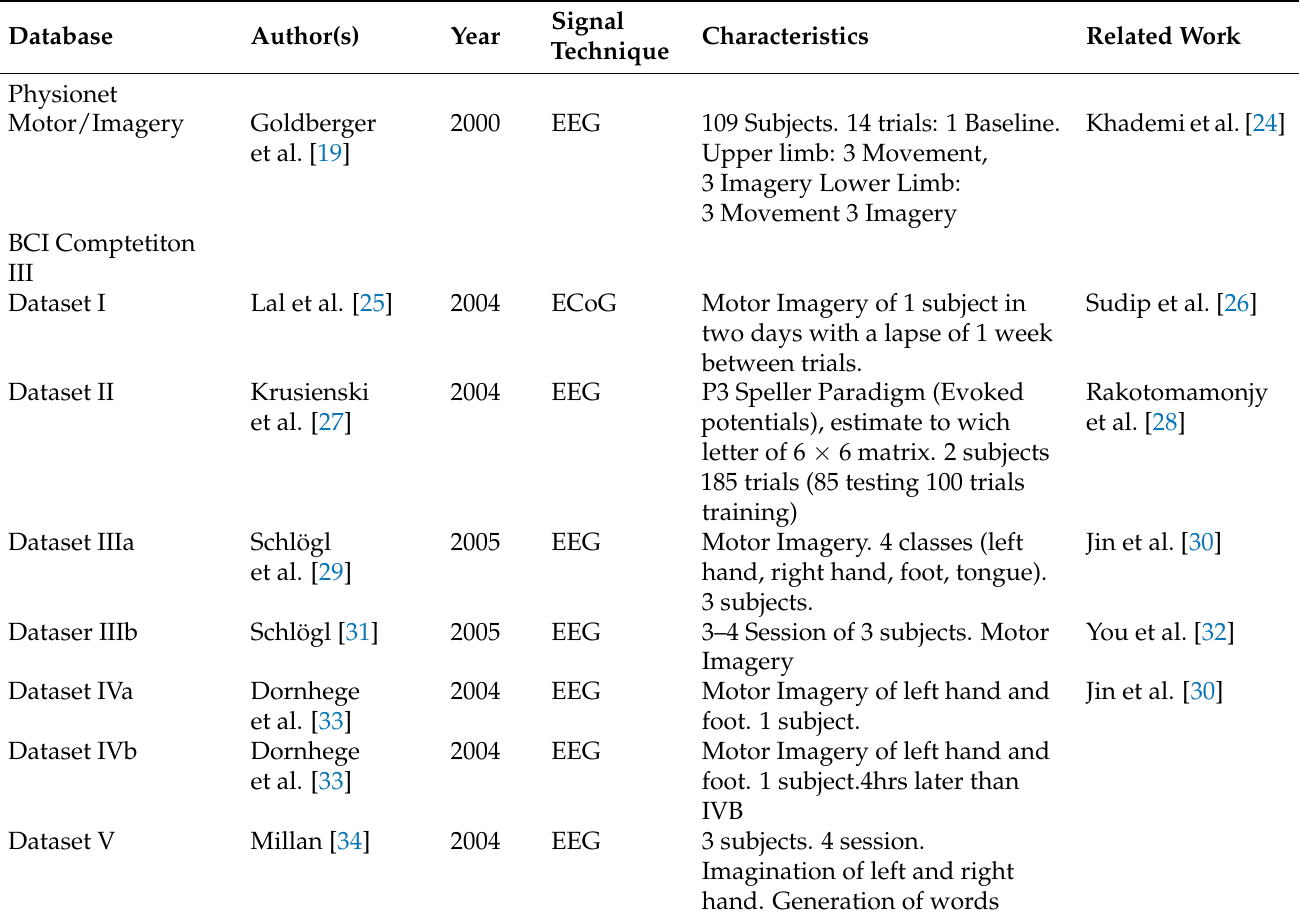
Table 1. Databases’